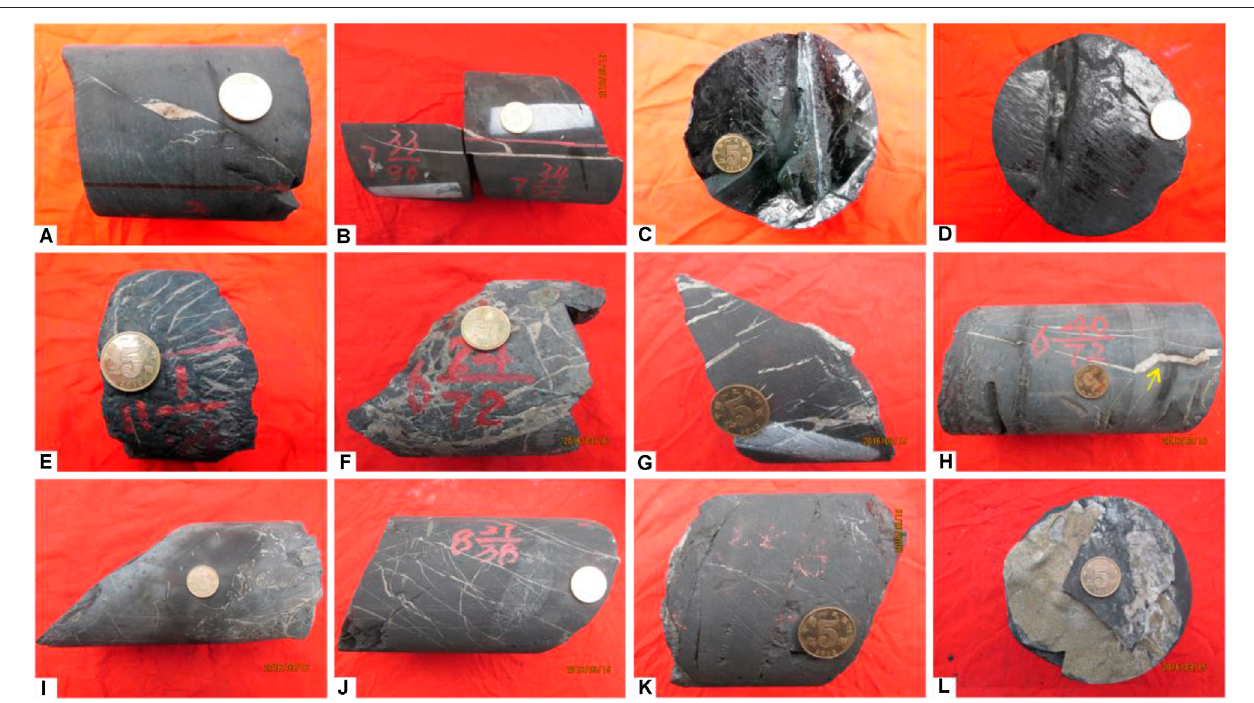
FIGURE6| FracturesinthecoresoftheNiutitangshaleofWellYX1. (A) 2019.4 m,highdip-angleshearfracturewiththesmall-sizedrhombicblock fi lledbycalcite; (B) 1998.25 – 2000.83 m, calcite - fi lled vertical shear fractures of 258 cm long and 1 – 3 mm wide; (C) 2024.7 m, low dip-angle slip fracture with scratches and steps developed; (D) 2019.3 m, horizontal slip fracture with a smooth mirror; (E) 2022.6 m, branched-shaped extensional fractures fi lled by calcite; (F) 1985.6 m, network extensional fractures fi lled by calcite; (G) 2006.0 m, parallelly arranged tensional-shear fractures with small branches and fi lled by calcite, the tensional-shear fractures were split by the slip fracture; (H) 1988. m, Jagged and calcite- fi lled tensional-shear fractures formed by tracking the X-type conjugate shear joints; (I) 1987.0 m, Jagged and calcite- fi lled tensional-shear fractures formed by tracking the X-type conjugate shear joints. The left side of the core has low dip-angle slip fracture; the right side was crushed and fi lled by calcite. (J) 2012.0 m, network fractures were formed by the conjugate shear fractures and the low dip-angle fractures associated with extensional fractures. The narrow fractures were fi lled with calcite, and the larger fractures were fi lled with calcite and quartz. (K) 2010.2 m, diagenetic bedding fractures; (L) 2004.0 m, overpressure fracture fi lled by pyrite, fi brous calcite and